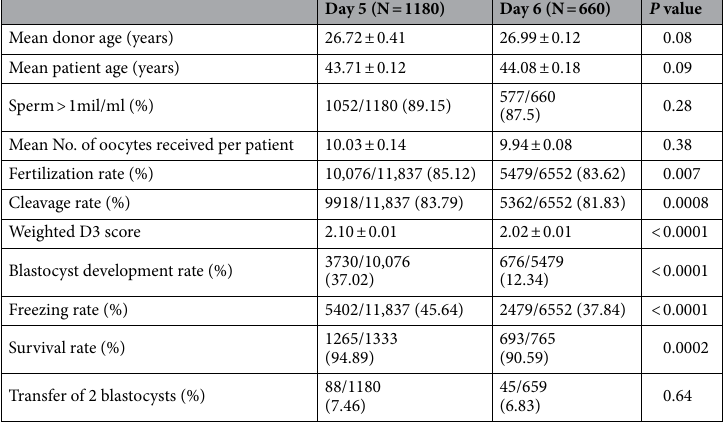
Table 1. Baseline and embryological characteristics of day 5 blastocysts vs. day 6 blastocysts cycles. Data is presented in mean ± standard error or